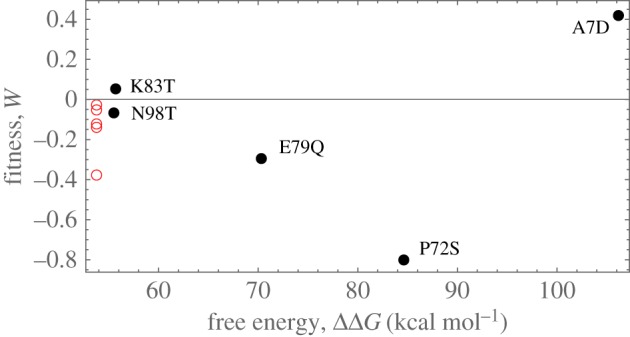
Experimental fitness measures of [45] against ΔΔGFX. Black bullets, AA substitutions; redrings, silent DNA substitutions. (Online version in colour.)